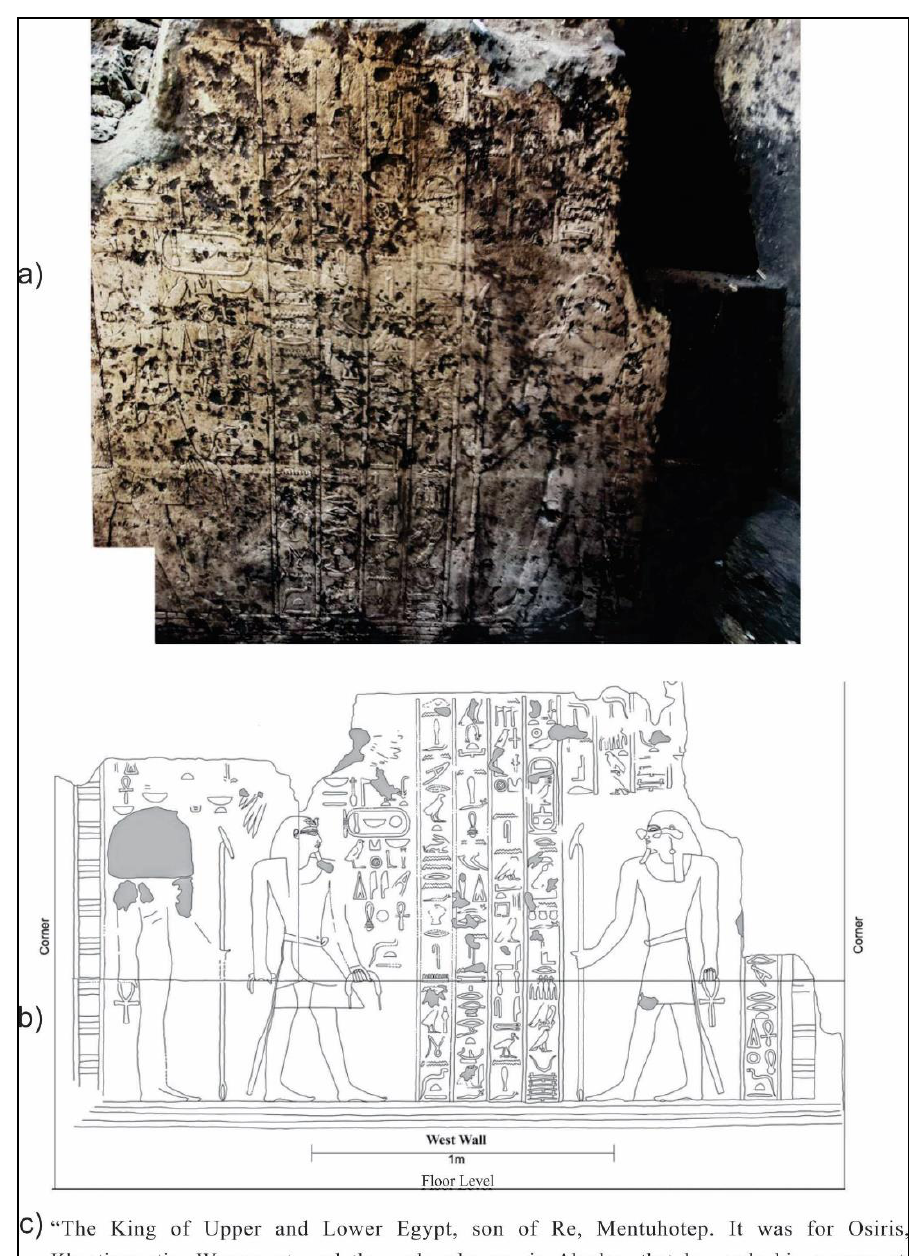
Figure 14. ( a ) Photograph of the wall after excavation, showing Neshmet on the right and Menit on the left, “the mooring post”; ( b ) the dedication text for the building is written on the west wall. Kevin Cahail and Jennifer Wegner collaborated on this illustration; and ( c ) detailed translation of the hieroglyphic writing claiming that the king dug a canal for the Abydene gods’ boats to be transported [26].